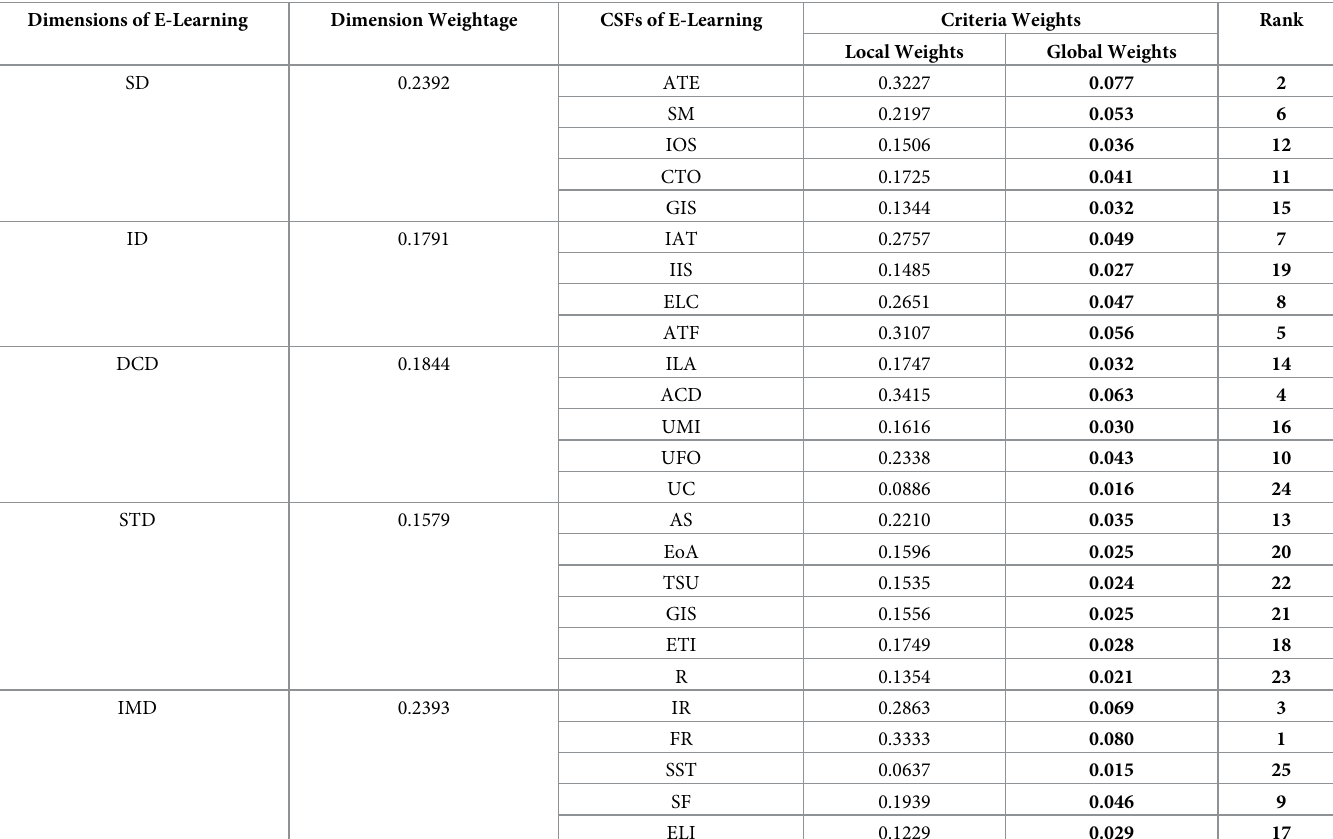
Table 12. Composite rank and weight of dimension and CSFs of E-Learning using